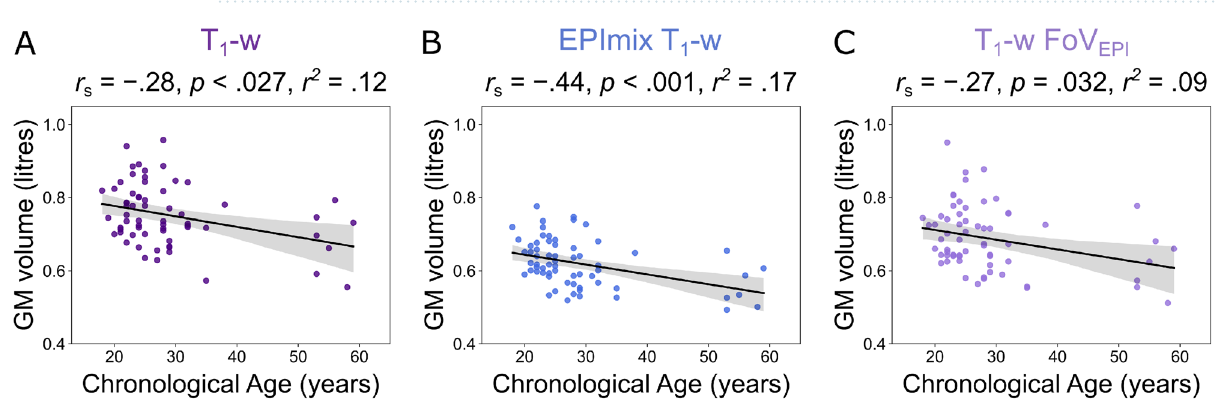
Figure 2. Voxel-wise tissue volume estimation across contrasts. Correlation between voxel-wise tissue volume estimates from T 1 -w and EPImix (T 1 -w) scans, and corresponding probability density plots, for grey matter ( A , B ), white matter ( C , D ) and CSF ( E , F ). Only voxels with at least 0.001 mm 3 tissue volume in at least 95% of participants are shown.